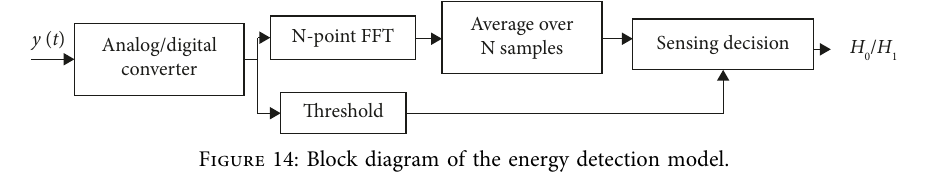
Figure 14: Block diagram of the energy detection model.